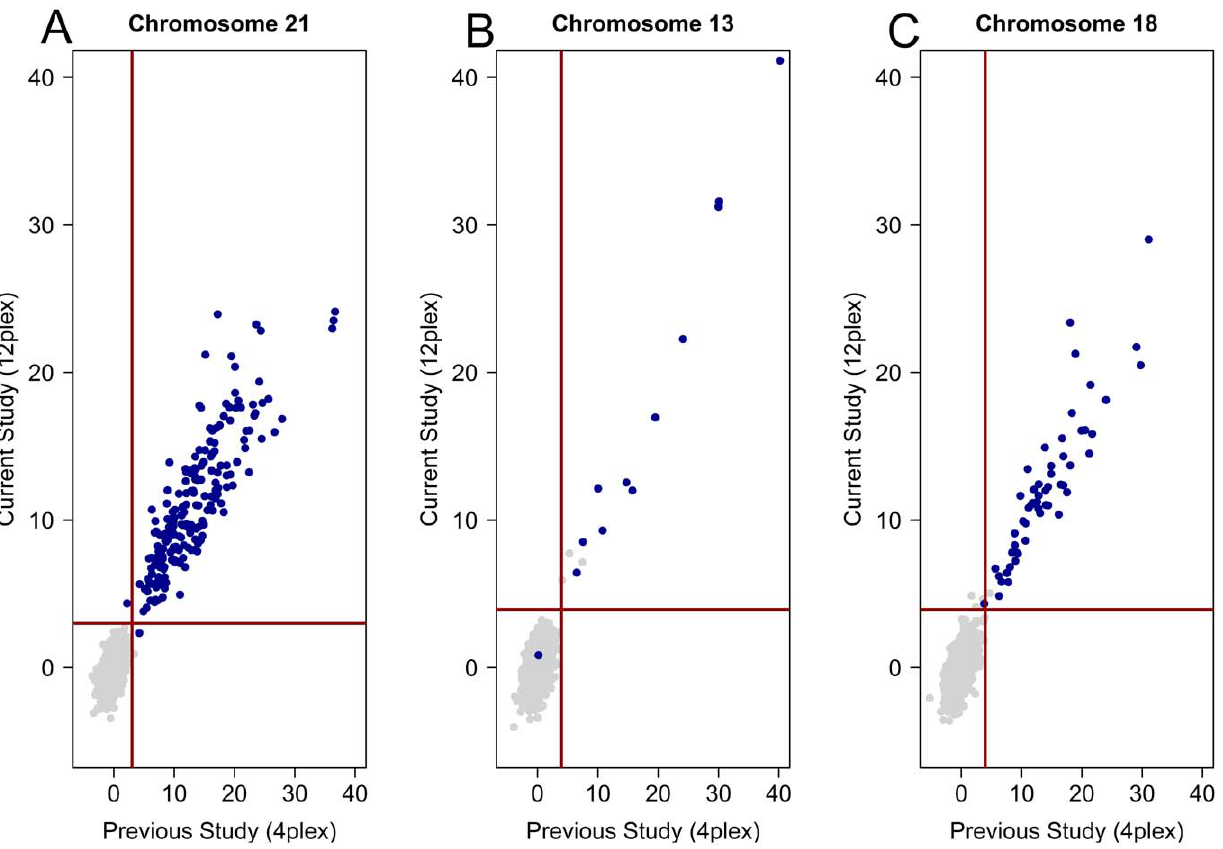
Figure 2. Paired comparison of z-scores. Z-scores were calculated for paired samples with previously described GC normalized, repeat masked z- scores on the x-axis [7] and z-scores from the same libraries sequenced in 12-plex on the y-axis. Samples classified by karyotype analysis as trisomies for A) Chromosome 21, B) Chromosome 13, or C) Chromosome 18 are shown in blue; unaffected samples for each aneuploidy condition are shown in gray. Red horizontal and vertical lines in each plot represent the respective classification cutoff for that chromosome (z=3 for chromosome 21, z=3.95 for chromosomes 13 and 18).